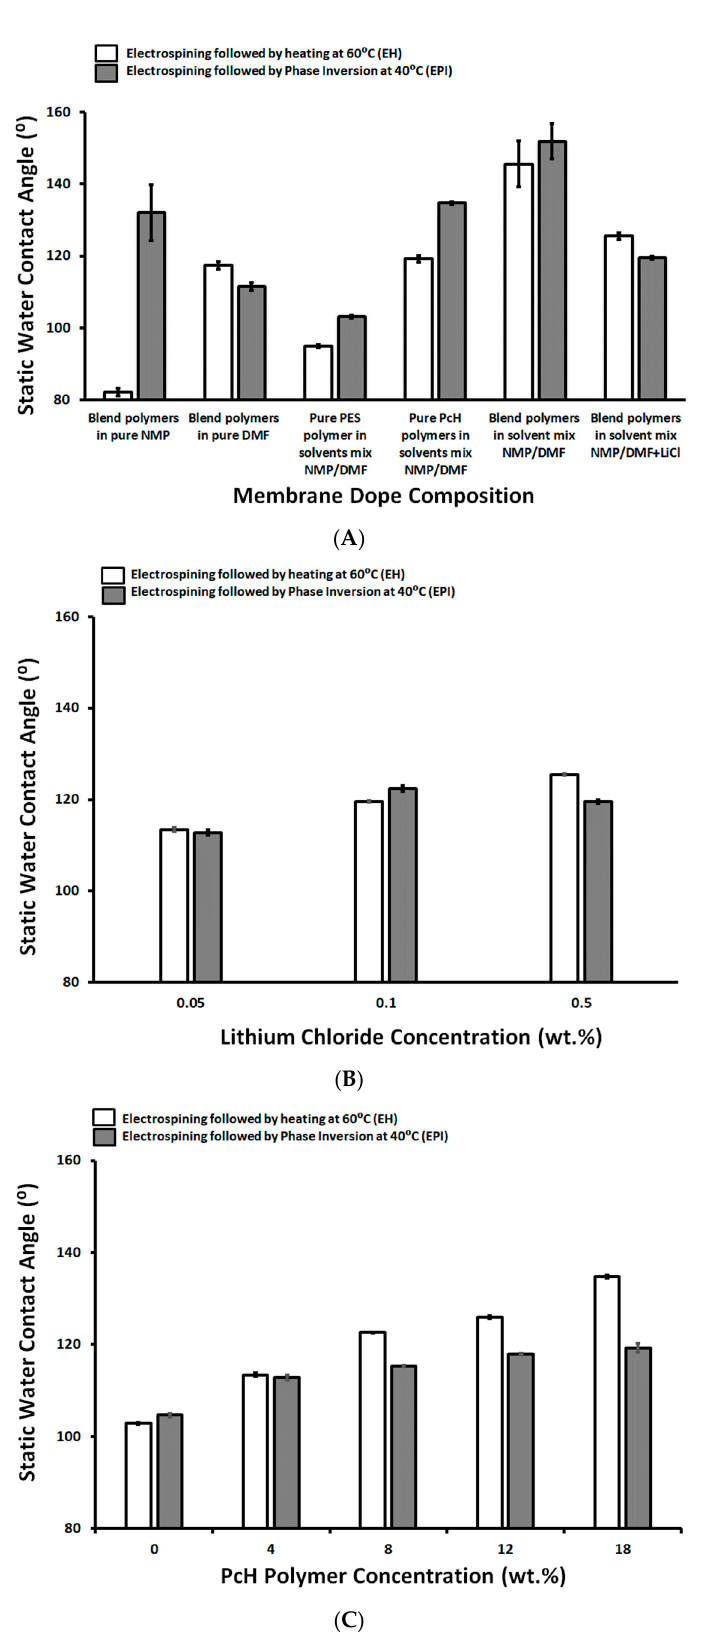
Figure 3. Static Water contact angle of different membrane dopes ( A ), as a function of Lithium chloride concentration (wt.%; B ) and as a function of PcH polymer concentration in the membrane dope (wt.%; C ).